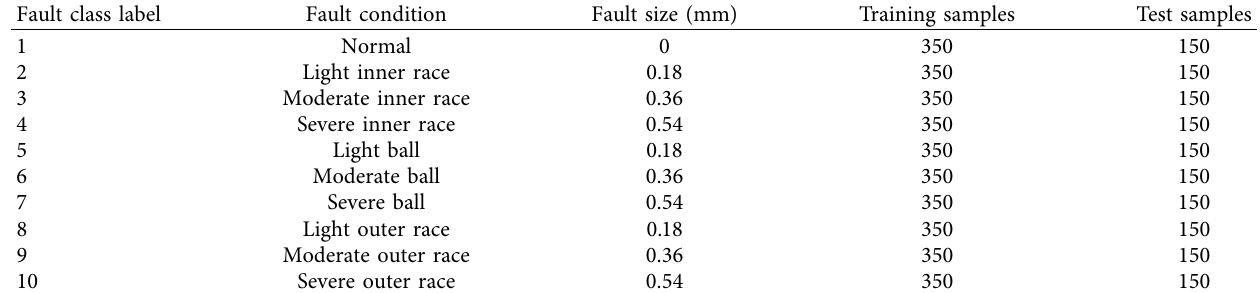
Figure 3: The photo and the schematic diagram of experiment rig. (a) The experimental setup; (b) the schematic diagram of the ex- perimental setup. Table 1: The faulty data statistics of rolling bearing.